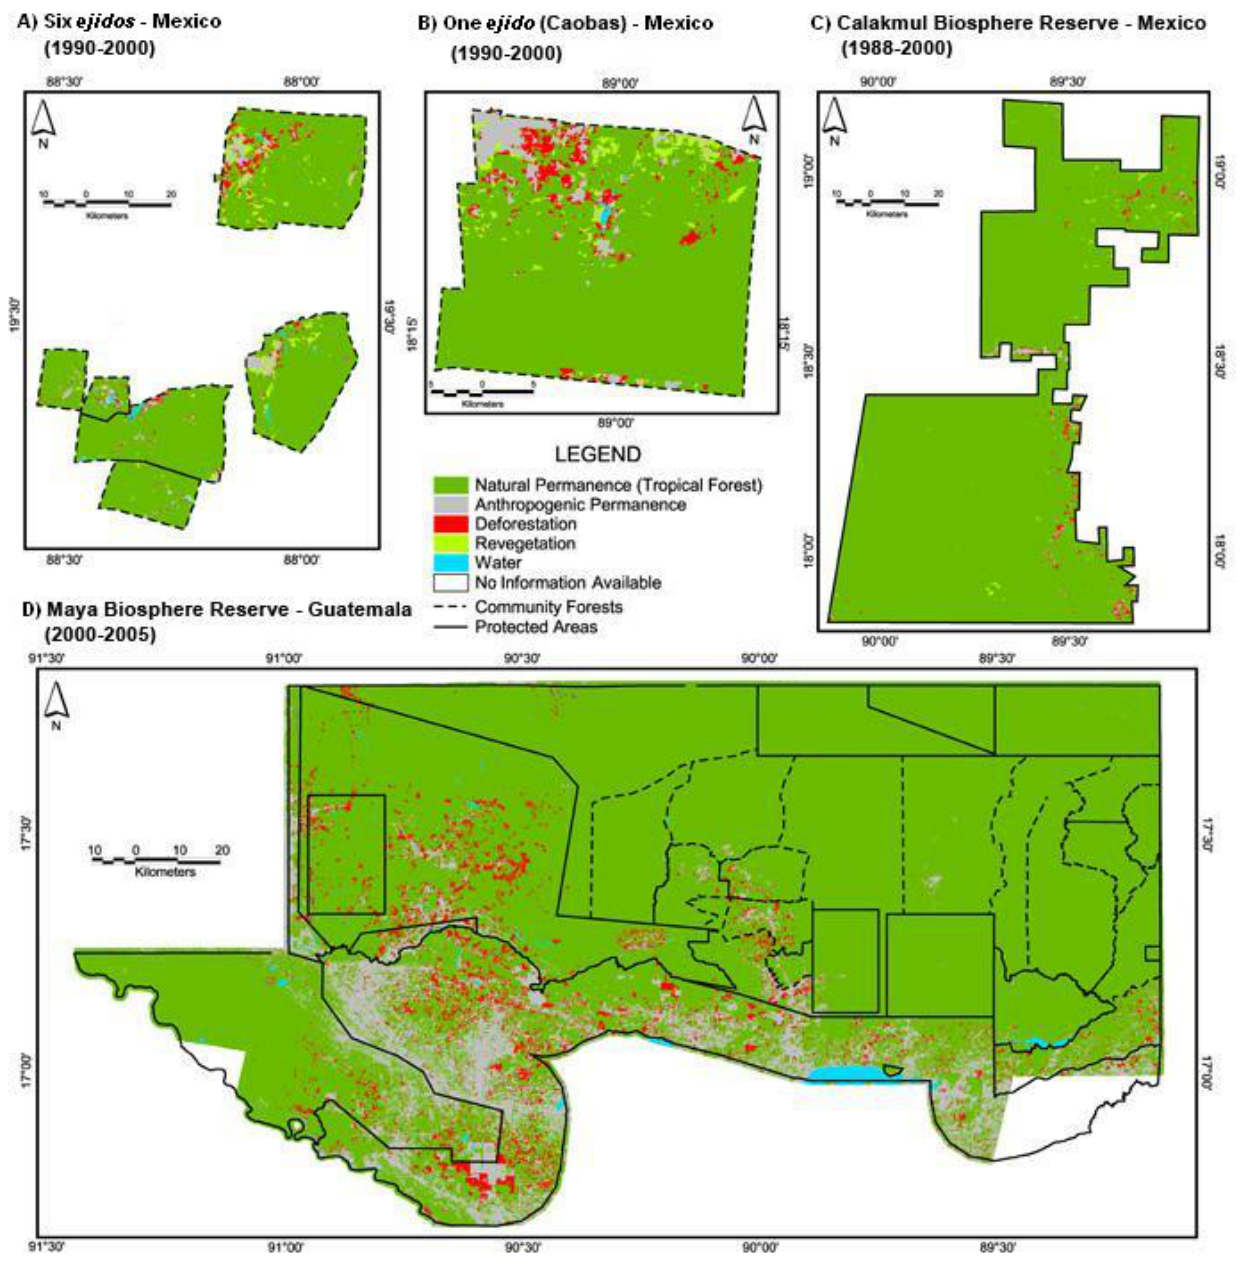
Fig. 2. Maps of land-use and land cover change processes for protected areas and community forests and the respective period analyzed. In Mexico: (A) six ejidos en Quintana Roo, (B) one ejido in Quintana Roo (Caobas), (C) Calakmul Biosphere Reserve in Campeche. In Guatemala: (D) Maya Biosphere Reserve; white areas indicate that no information was available. Used with permission from Consejo Civil Mexicano para la Silvicultura